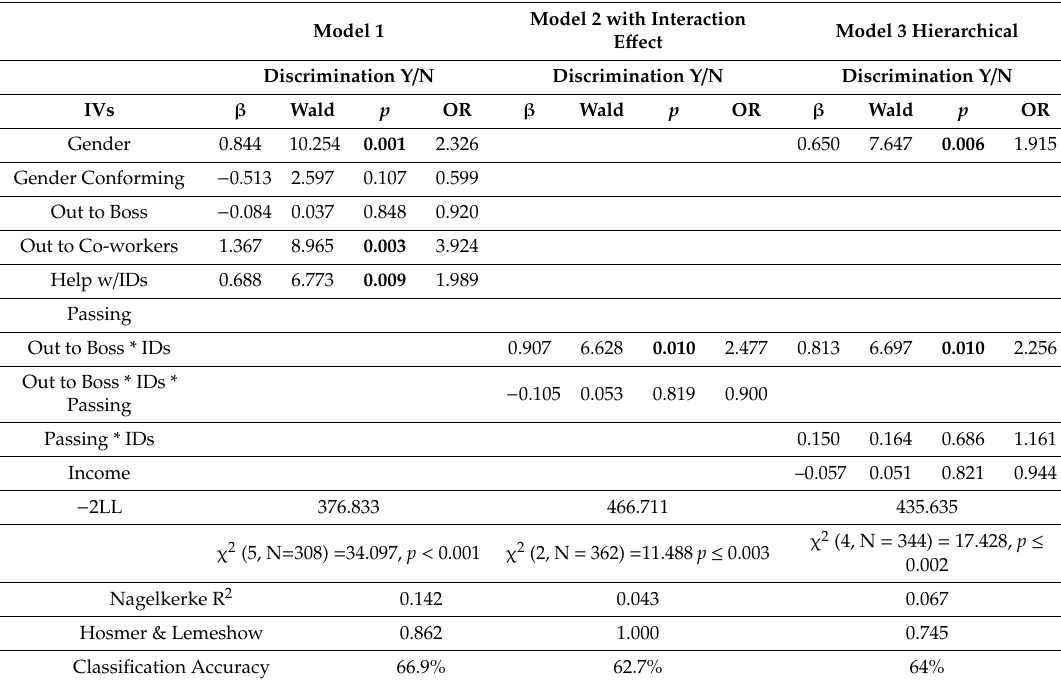
Table 4. Logistic Regression: Likelihood of Experiencing Discrimination in the